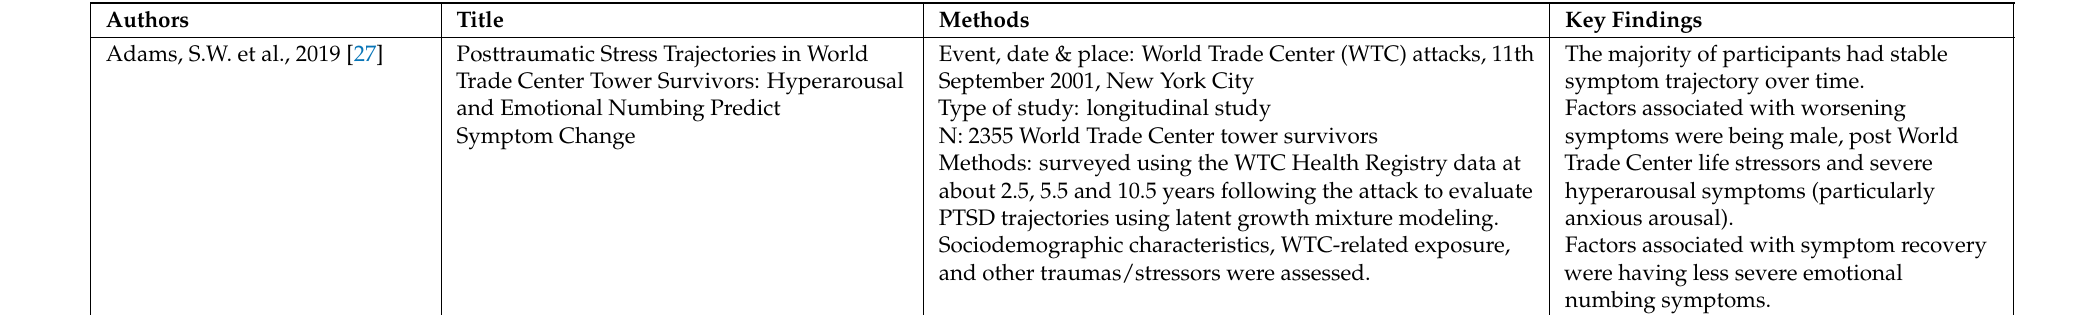
Table 2. Risk factors for development of mental disorders after terrorist